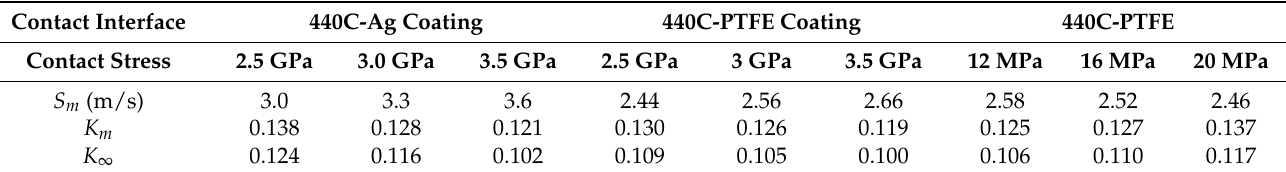
Figure 4. The maximum relative errors are all less than